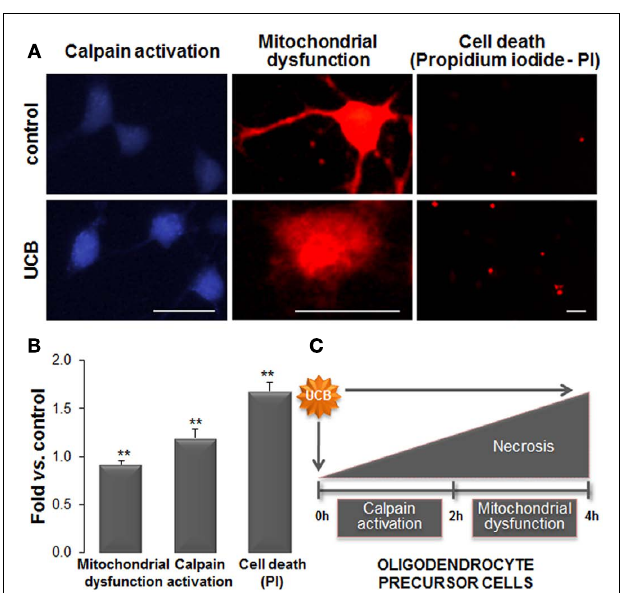
FIGURE 8 | Exposure of oligodendrocyte precursor cells (OPCs) to unconjugated bilirubin (UCB) leads to mitochondrial dysfunction, followed by calpain activation, and cell death. Primary cultures of OPCs were isolated from mixed glial cultures and stimulated to differentiate. OPCs were treated with 100 μ M of human serum albumin (HSA; control) or 50 μ M UCB plus 100 μ M HSA for 24h (UCB). Mitochondrial functionality was evaluated by Mitotracker Red. Endoplasmic reticulum stress was assessed by the activity of calcium-dependent calpain using a specific calpain substrate. Necrotic-like cell death was evaluated by propidium iodide (PI) through the emission of red fluorescence. (A) Representative results of one experiment. (B) Graph bars represent the fold increase in staining intensity comparatively to control (mean ± SEM) in labeled active mitochondria (red), in calpain activity (blue), and in PI + cells (red) from at least three independent experiments performed in duplicate. (C) Effects produced by UCB in OPCs start by mitochondrial dysfunction that induces the increase in intracellular calcium levels and activation of calpains.This cascade of events culminates in OPCs demise. Impairment of OPCs differentiation into oligodendrocytes by UCB will determine defective myelination. Scale bar represents 20 μ m. ** p < 0.01 vs. control. Data derived from Barateiro et al.